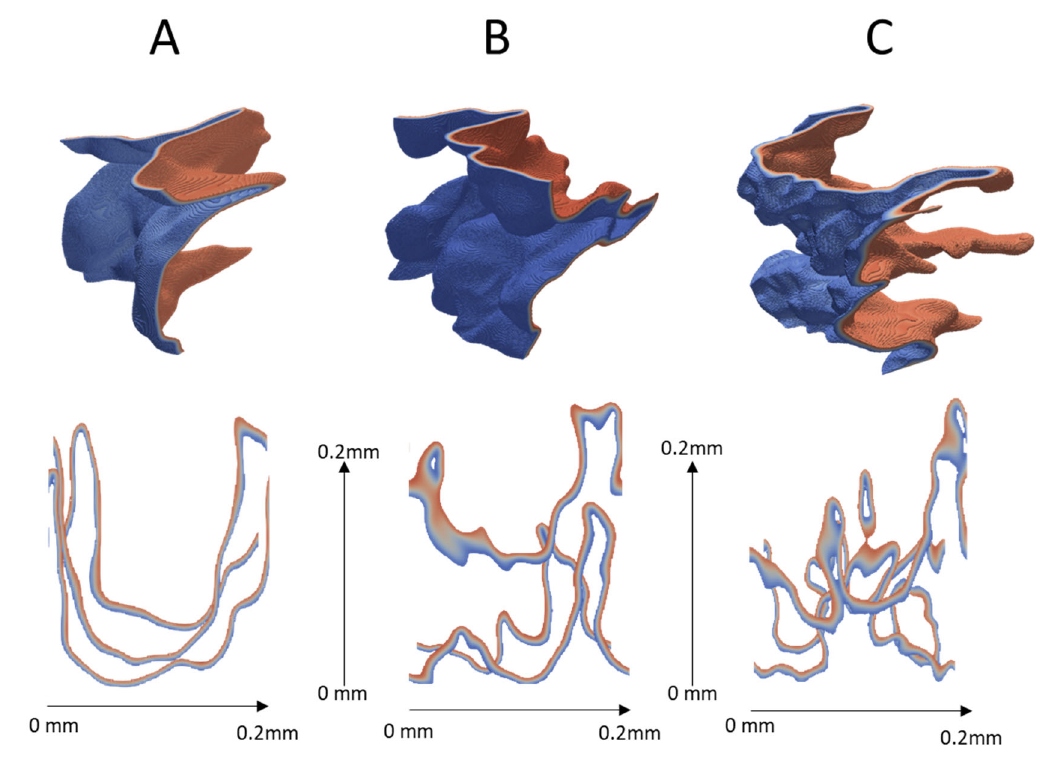
Figure 4. Three ‐ dimensional depictions and two ‐ dimensional slices (three each) of flame fronts from three DNS ‐ simulated premixed combustion cases ( A – C ). The slices show the inner patterns. The colour range for filtering the flame fronts is from 1000 K (blue) to 3000 K (red).